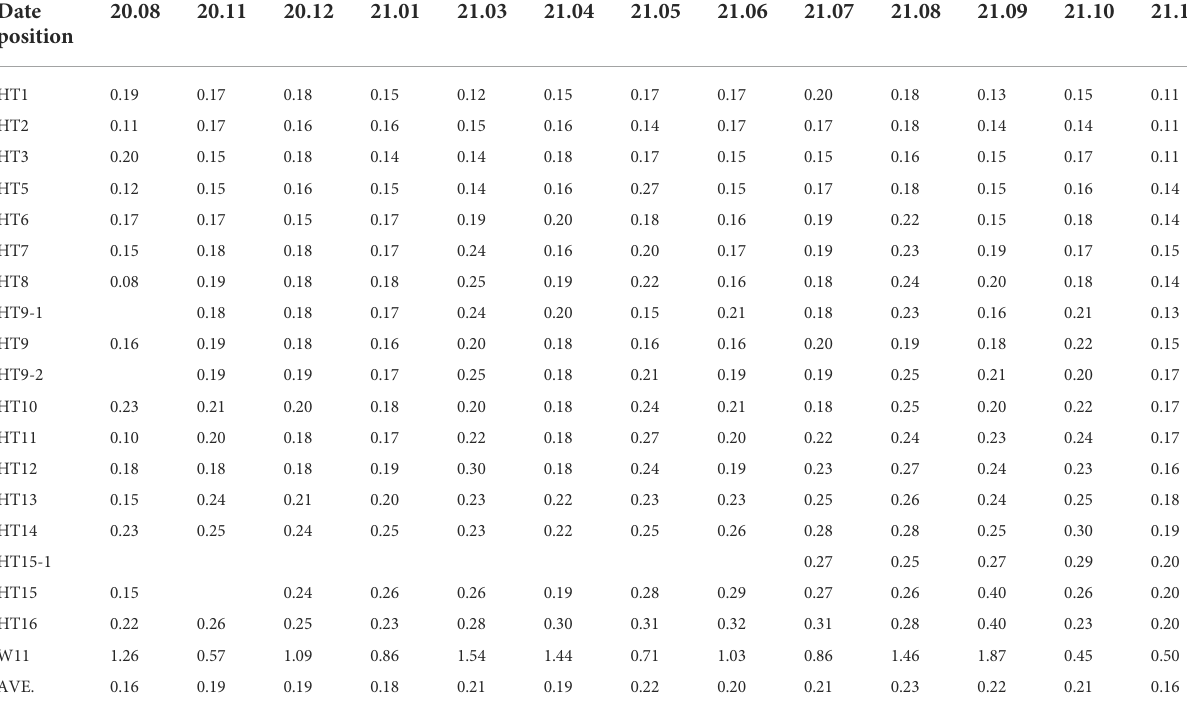
TABLE 2 Data of fl uorine concentration in different months in Huatan River Basin (mg/L).